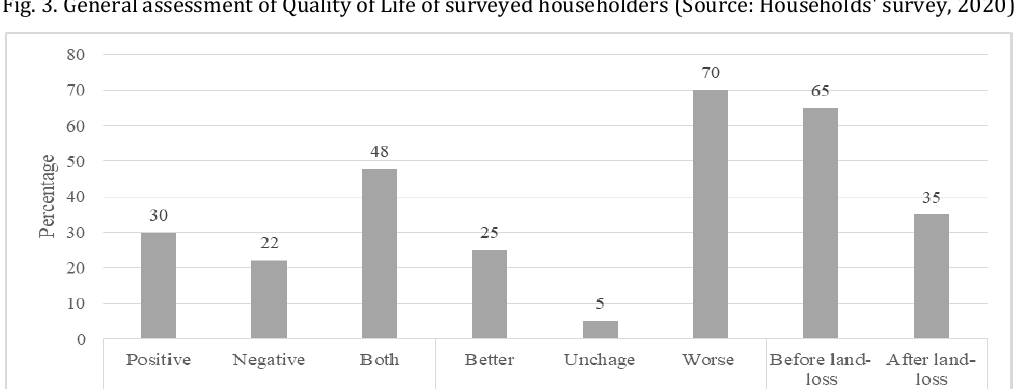
Fig. 3. General assessment of Quality of Life of surveyed householders (Source: Households' survey, 2020)